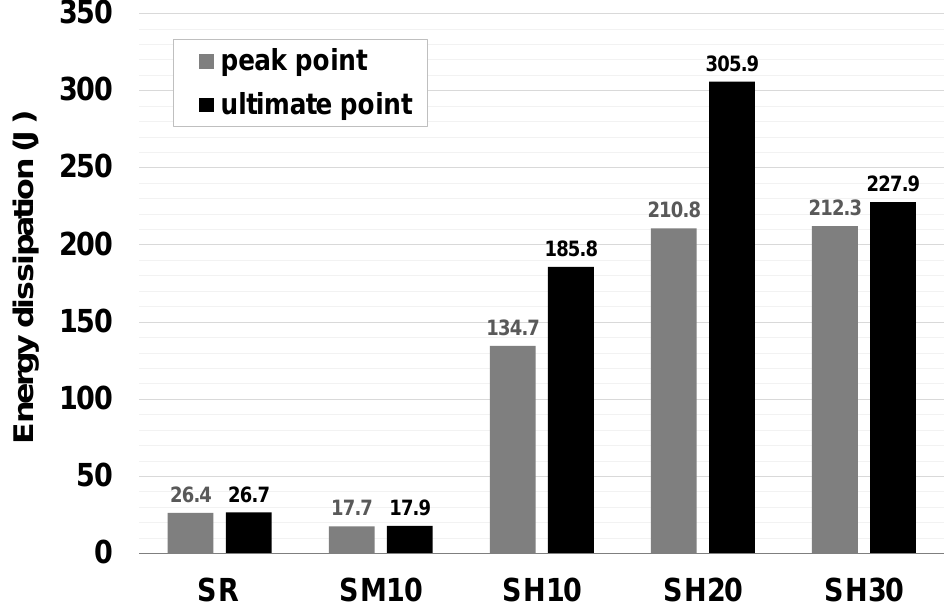
Figure 10. Energy dissipation capacity of specimen #1 for each variable.